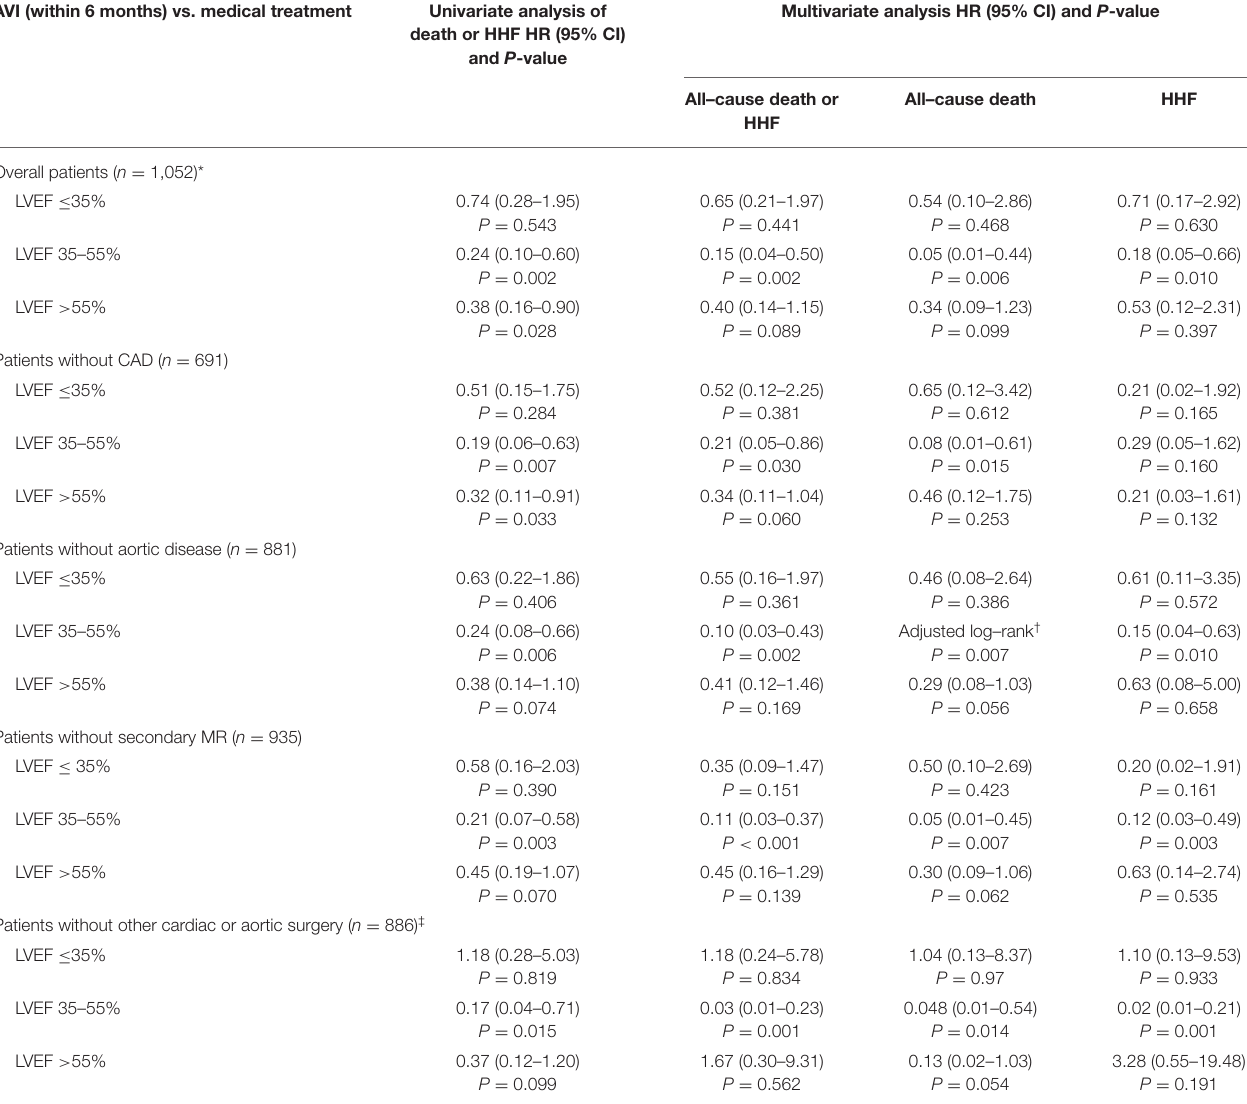
TABLE 4 | Impact of treatment strategies on the primary outcome and its components according to the LVEF ranges and sensitivity analyses. AVI (within 6 months) vs. medical